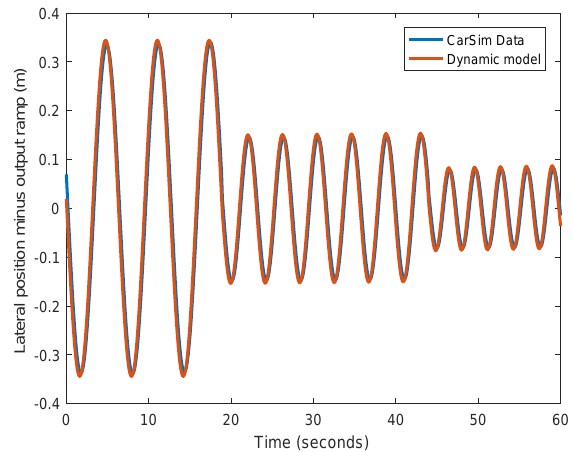
Figure 5. Open-loop responses of the CarSim plant and the identified model without the ramp.